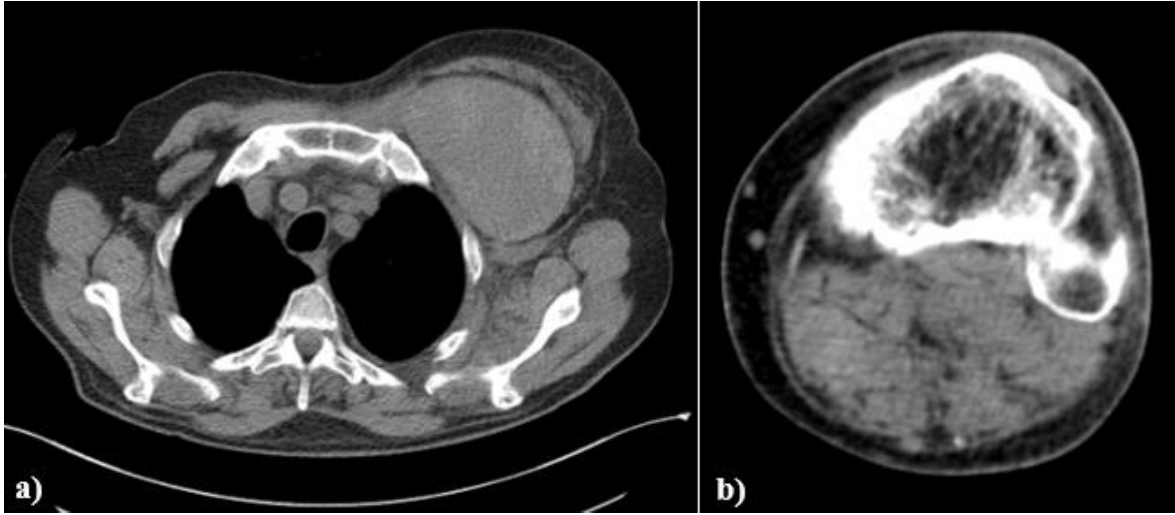
Figure 3. ( a ) Thorax CT scan evidencing left sub-pectoral hematoma; ( b ) computed tomography of the left calf showing a profound